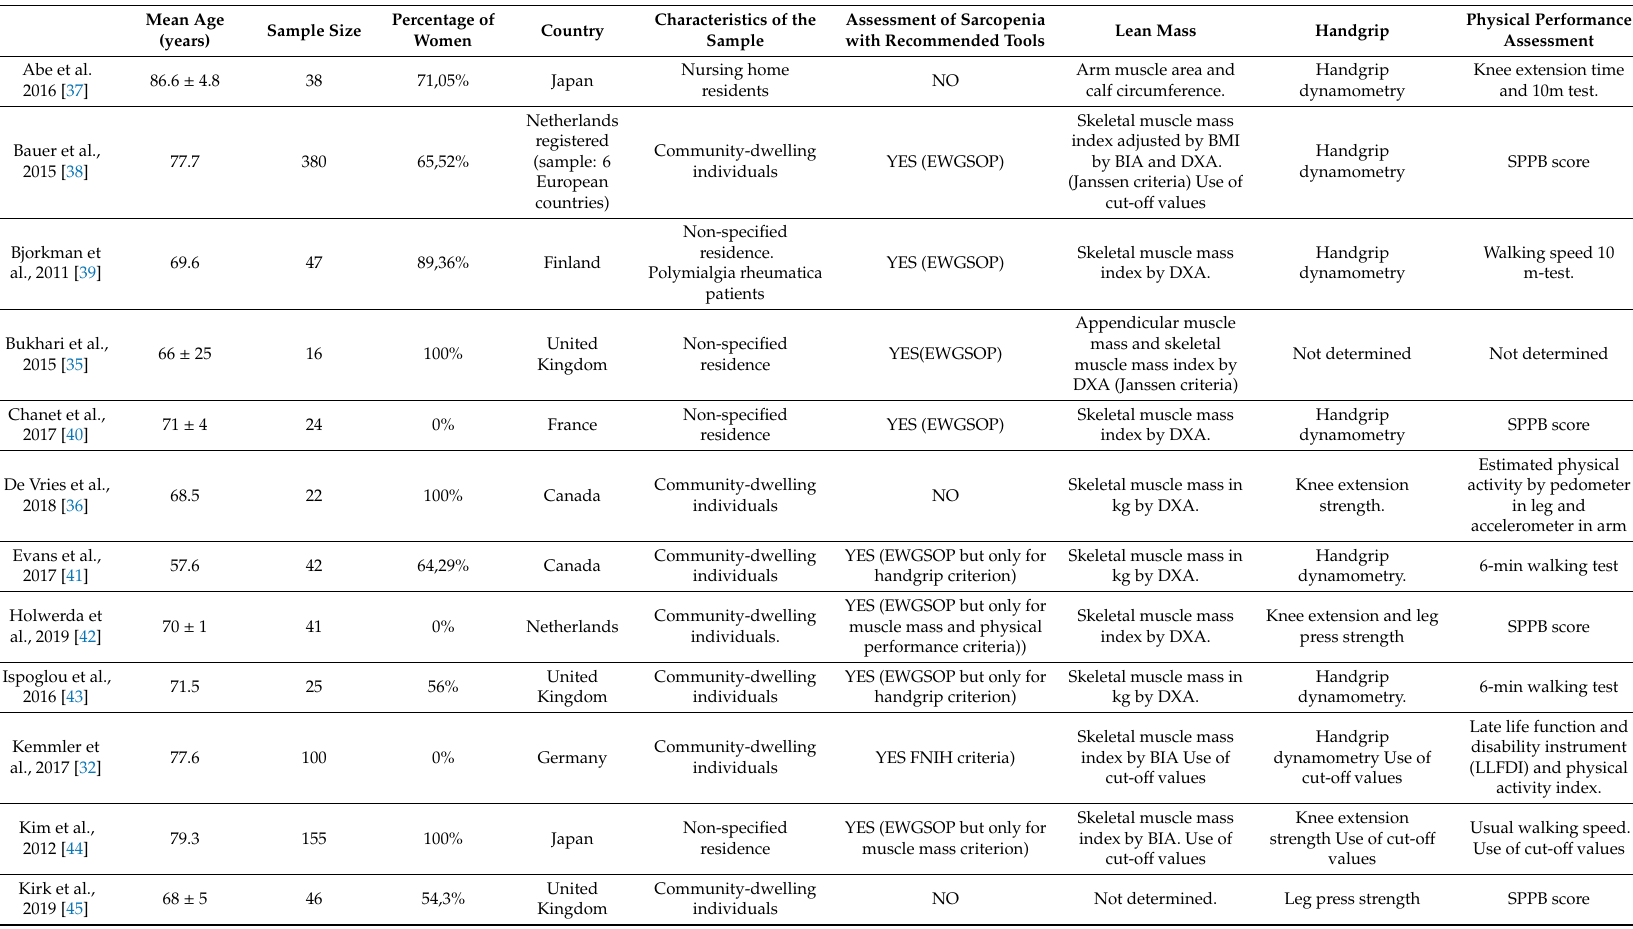
Table 1. Main characteristics and measurement of three sarcopenia criteria in the analysed